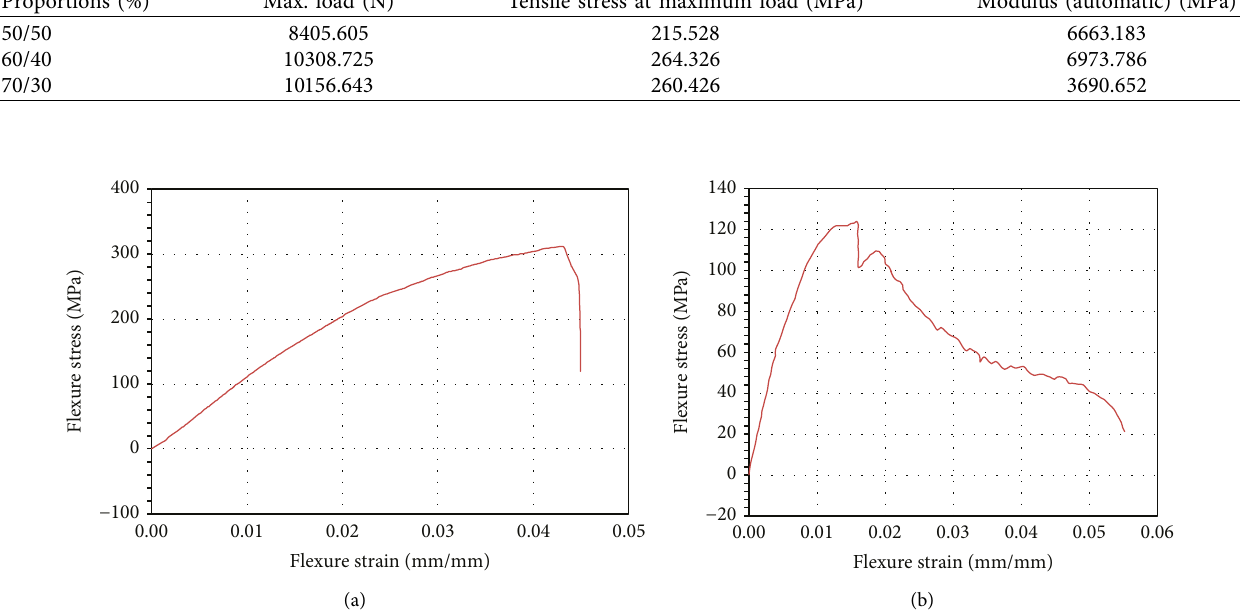
Figure 7: Flexural behavior of (a) 50/50% and (b) 60/40% glass/epoxy composite plate.